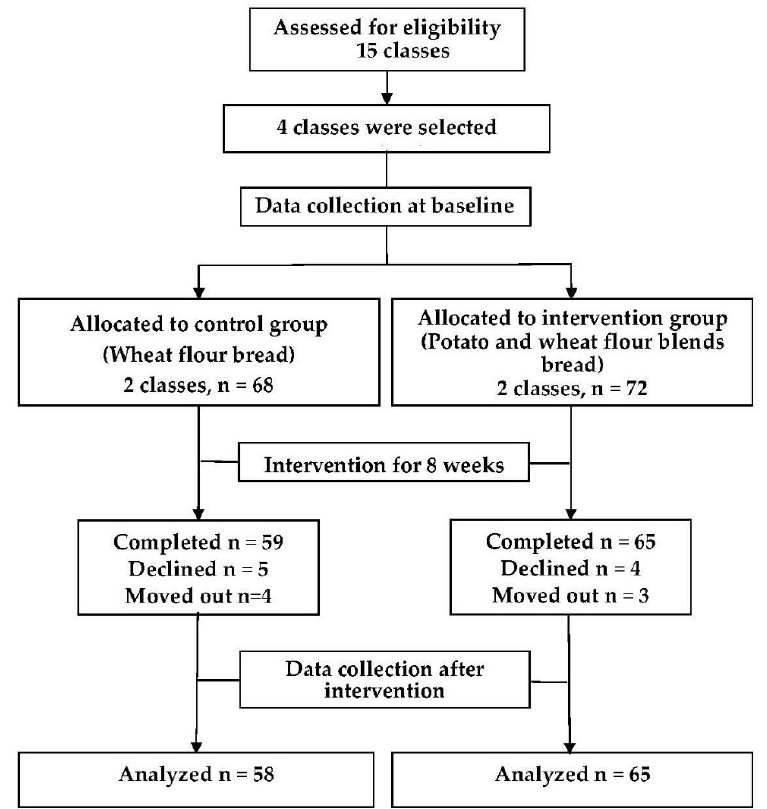
Figure 1. The CONSORT flowchart of the study.